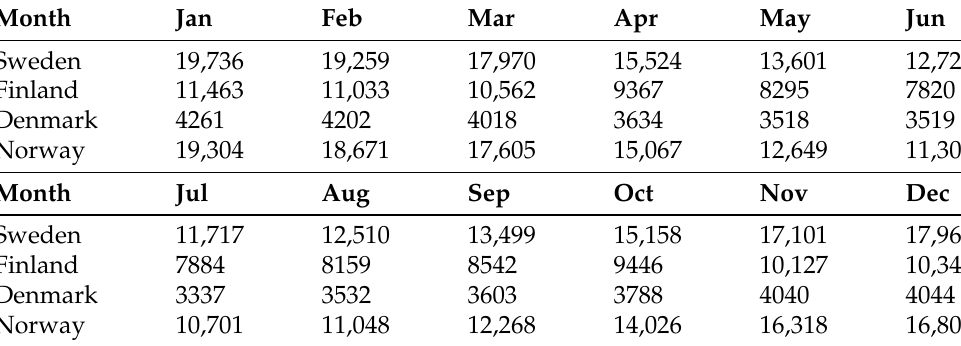
Table 1. Average consumption to Nord Pool’s customers measured in MWh per hour in all months of the year in the years 2013–2020 in the four Nordic countries. Month